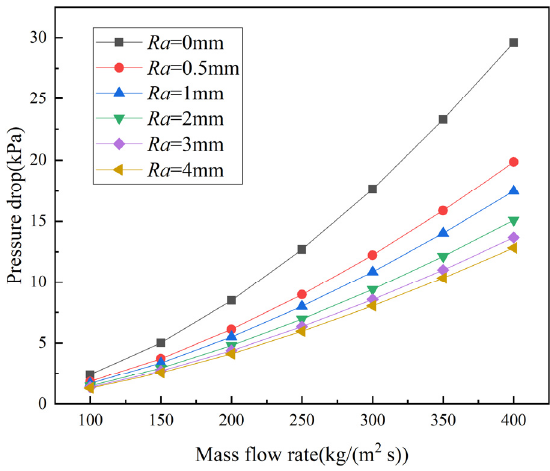
Figure 11. Pressure drop values of PCHEs at different mass flow rates for different curvature radii of arc segments.